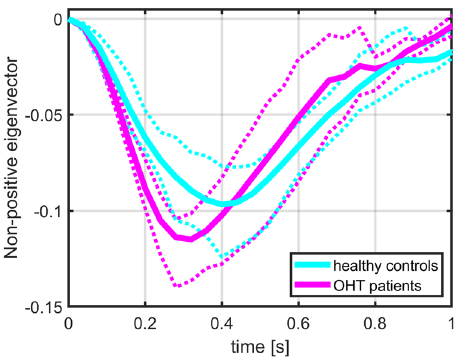
Fig. 6 Group averaged OCP pulses with 25 – 75% con fi dence intervals. Con fi dence intervals are visualized as color-matched